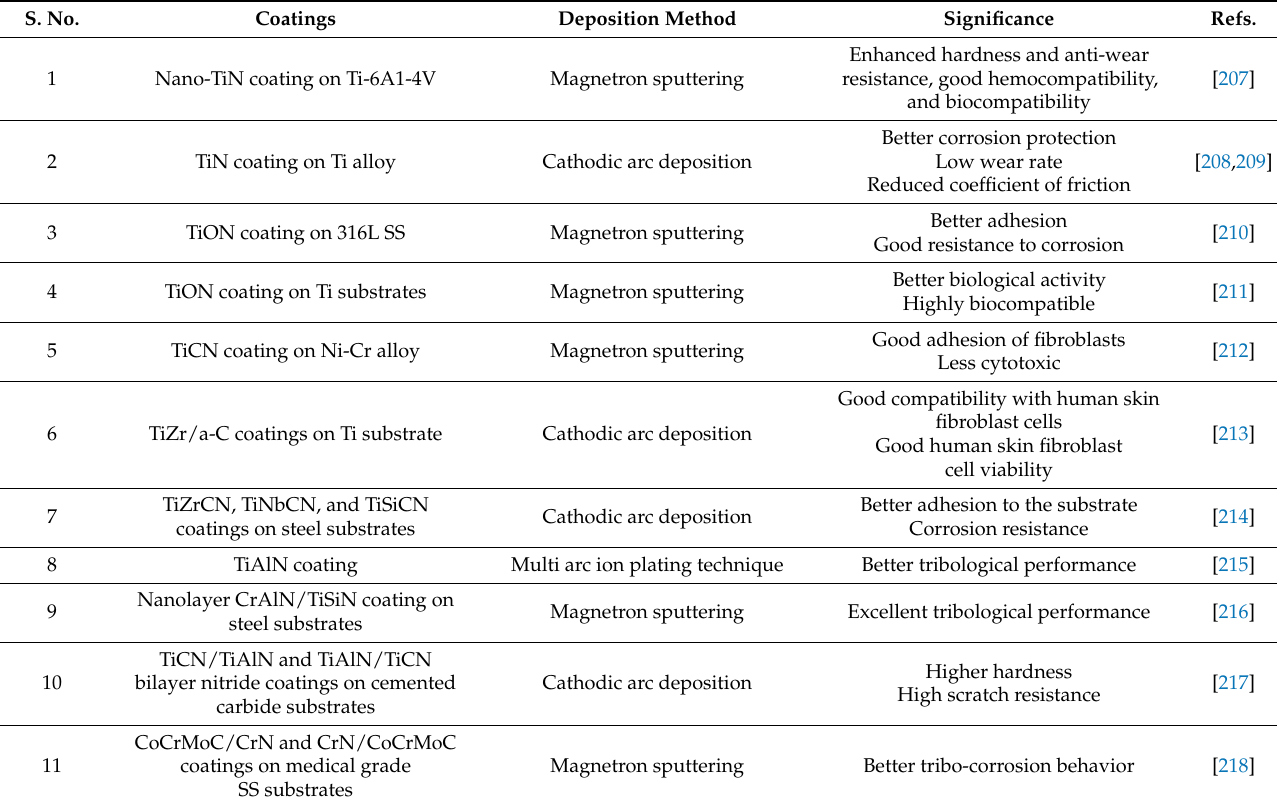
Table 5. Recent work on binary, ternary, and quaternary systems of transition metal nitride and carbide coatings for implant